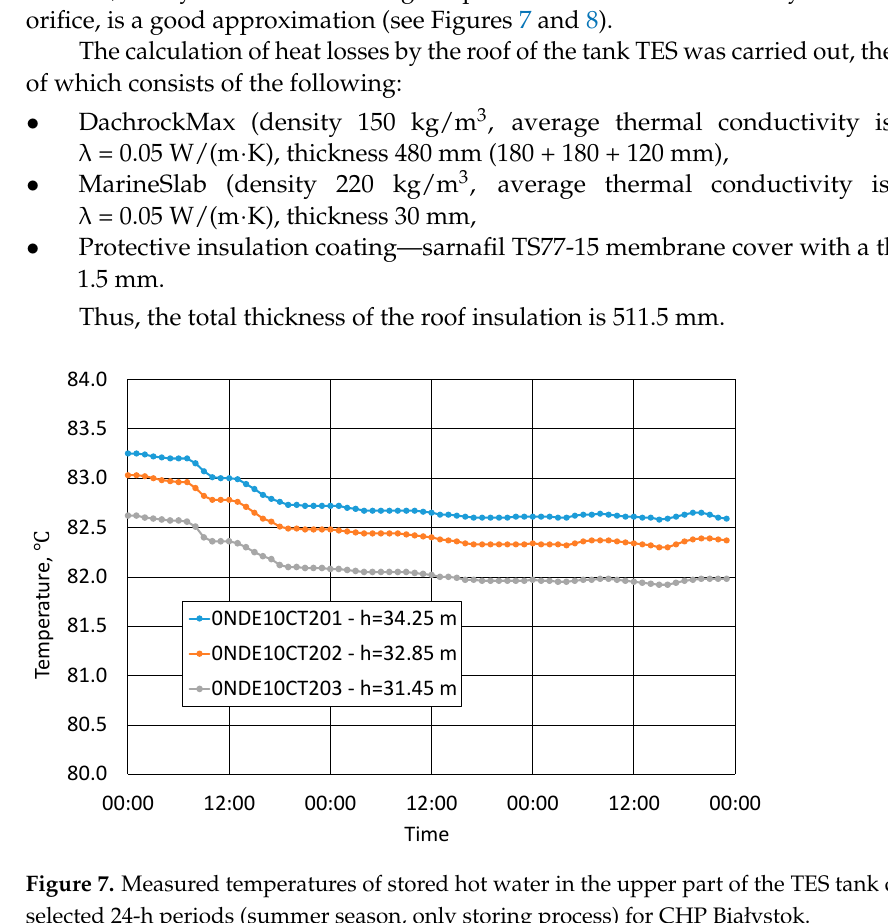
Figure 7. Measured temperatures of stored hot water in the upper part of the TES tank during three selected 24-h periods (summer season, only storing process) for CHP Bia ł ystok.